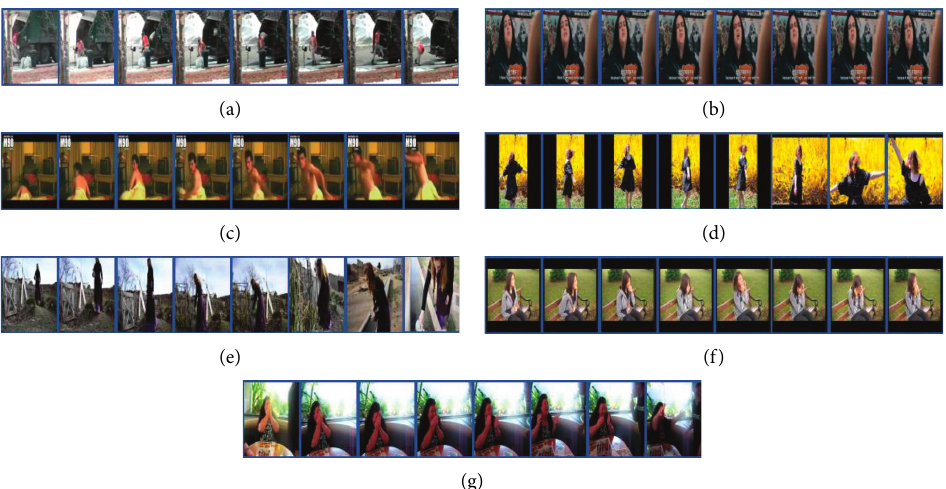
Figure 3: Example frames of each emotion category from the HEIV dataset. (a) Anger. (b) Disgust. (c) Fear. (d) Joy. (e) Neutral. (f) Sadness. (g) Surprise.